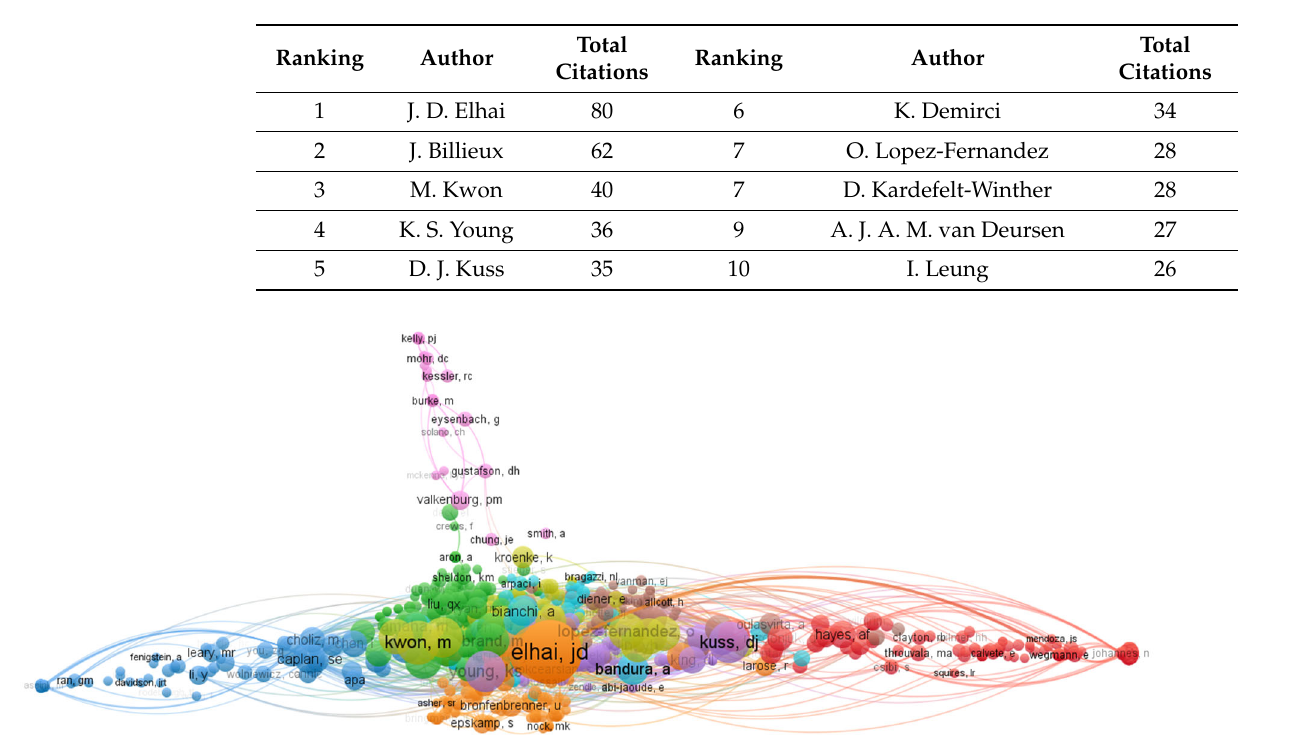
Figure 6. Co ‐ citation analysis of cited authors.